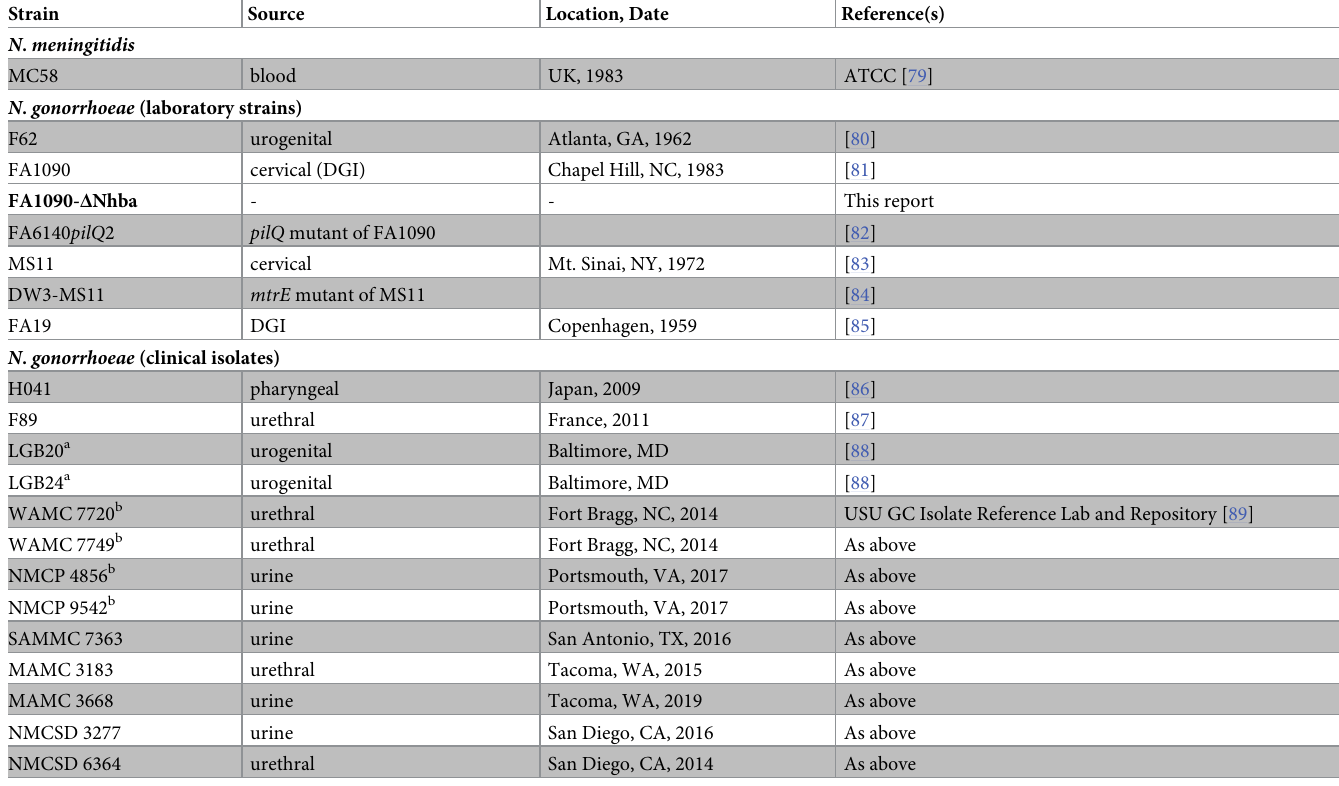
Table 2. Bacterial strains used in this